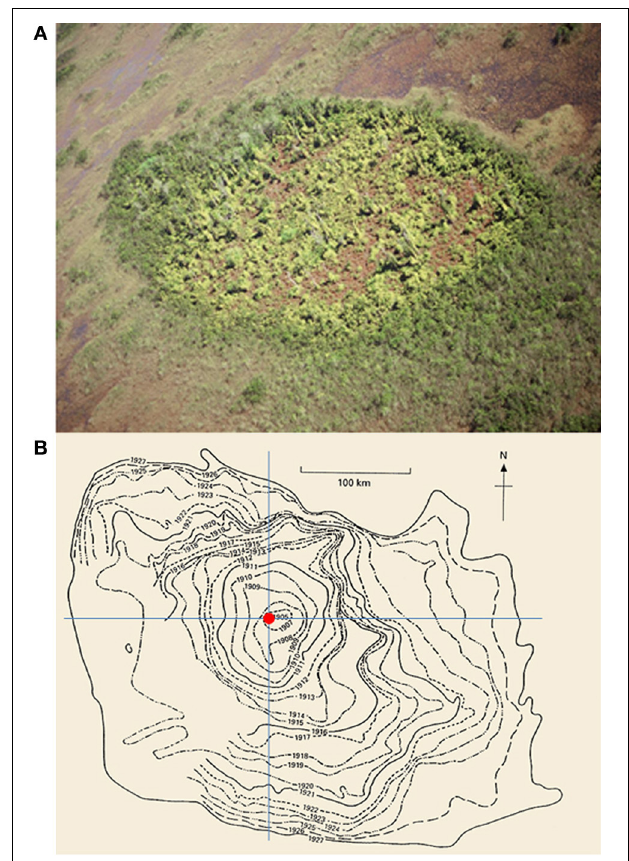
FIGURE 1 | (A) An example of new invasions of Old World climbing fern ( Lygodium microphyllum ) at the patch-level in the greater Everglades ecosystem of southern Florida, USA (photo courtesy S. Miao). (B) The historical spread of muskrats ( Ondatra zibethicus ) at the range-level in central Europe from 1905 to 1927 (after Elton, 1958; see also Shigesada and Kawasaki, 1997).